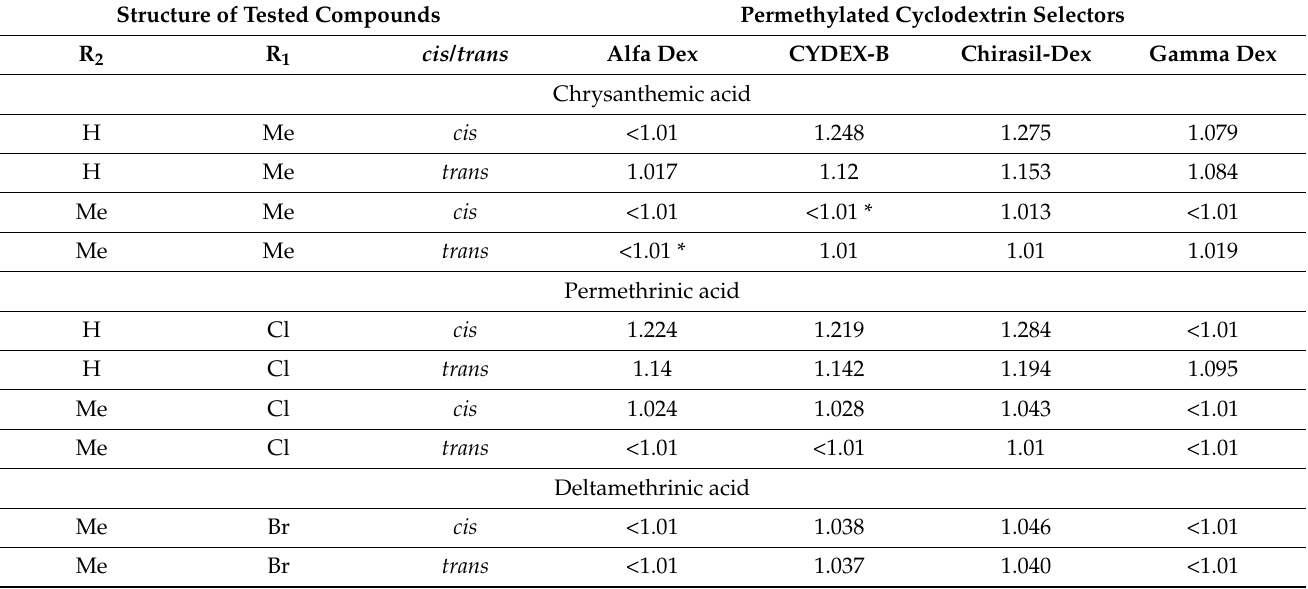
Table 1. The chiral selectivity values of pyrethroic acids for different ring-sized permethyl cyclodex- trins containing stationary phases at 100 ◦ C.